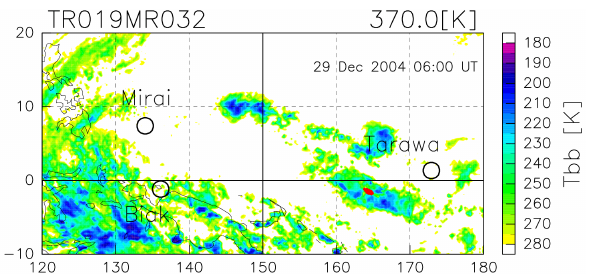
Fig. A3. Match air segments (red area at ∼ 2 ◦ S, ∼ 164 ◦ E) similar to the red dots in Fig. 1 superposed on the distribution of T bb (color) at 06:00UT on 29 December 2004. The black circles show the cir- cles of the match radius (1 ◦ ) centered at individual observational stations.